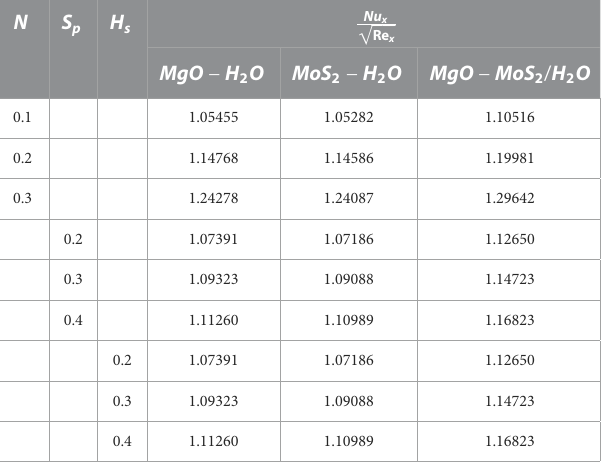
TABLE 3 Impacts of different physical factors on the Nusselt number. N